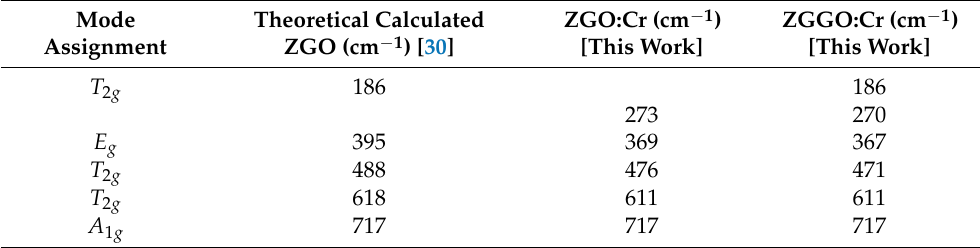
Table 1. Frequency of the vibrational modes measured experimentally in this work for ZGO:Cr and ZGGO:Cr. For comparison, the theoretical values for ZGO calculated in ref [30] are also included. Mode